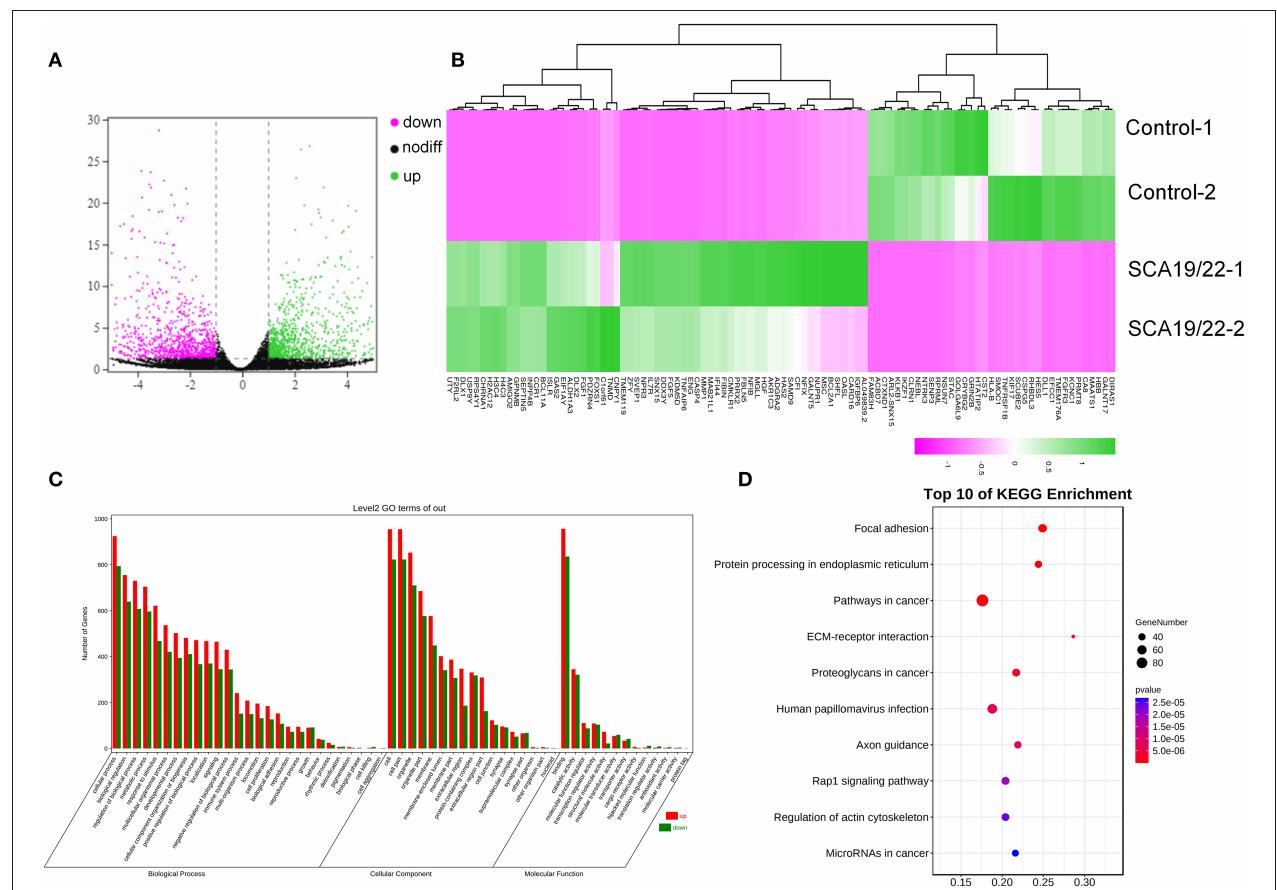
FIGURE 5 | A visualization of the transcriptome data analysis. The volcano map (A) and heatmap (B) of the gene expression. The red gene is upregulated and the green gene is downregulated. |log2 (FC)| > 1 is considered to be significant. Significant enrichment of GO (BP, CC, and MF) (C) ; the KEGG pathway showed protein processing in the endoplasmic reticulum, and focal adhesion was significantly enriched (D)